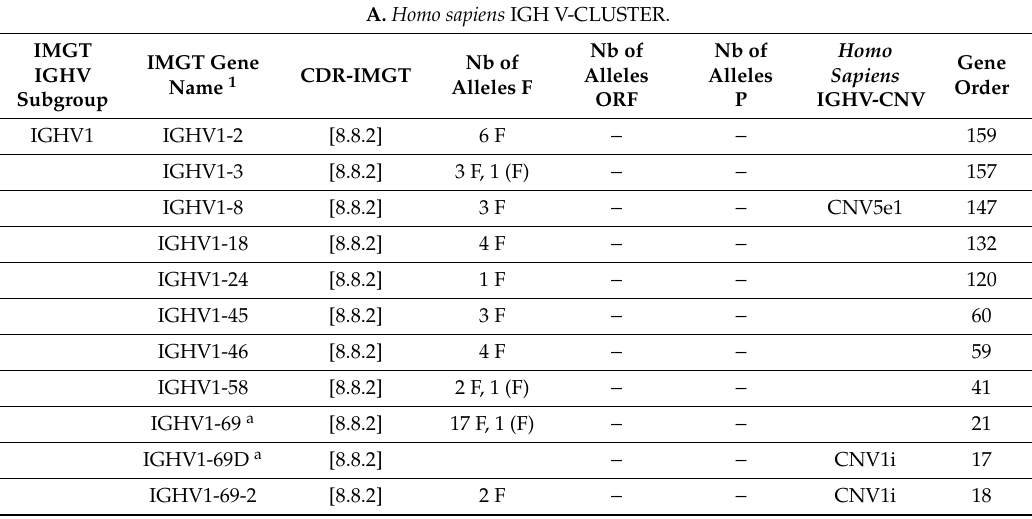
Table 7. Potential Homo sapiens IGH genomic